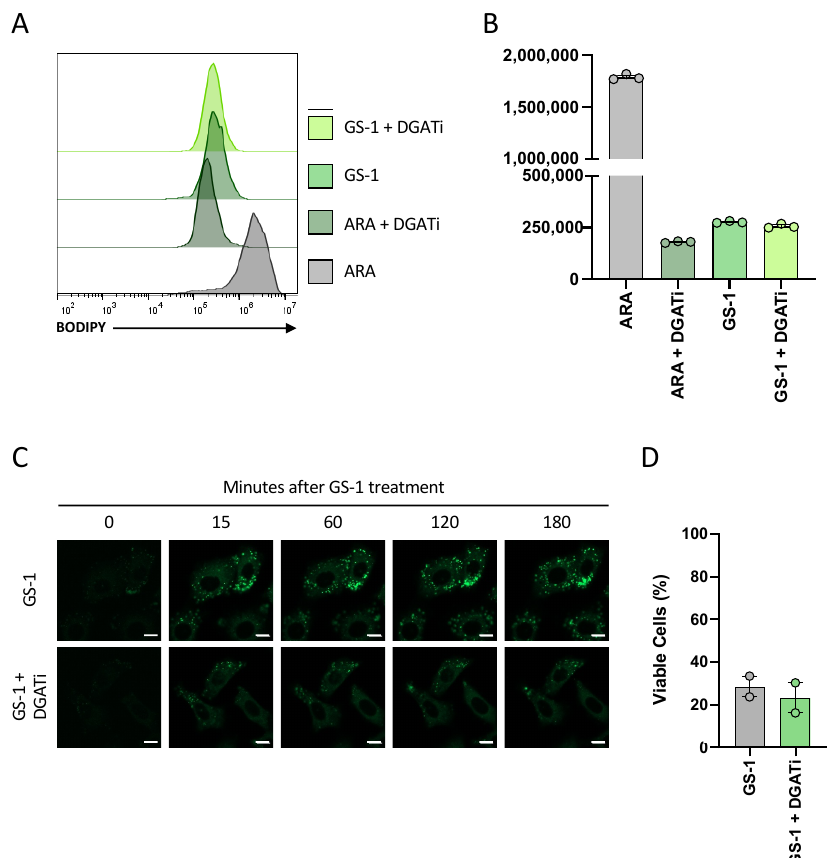
Figure 6. Role of LD in GS-1 cytotoxicity. A549 cells were treated with GS-1 and DGATi for 4 h before being stained with BODIPY. (A) BODIPY levels were plotted as histograms after flow cytometry analysis. BODIPY MFI was then quantified in (B) (Representative of n=3 experiments, ± S.E.M). (C) Confocal time course microscopy analysis of A549 cells treated with GS-1 in the presence of DGATi and stained with BODIPY (scale bar 10 µm; images representative of 3 ex-periments). (D ) A549 cells were treated GS-1 with or without DGATi for 24 h before undergoing an MTT assay to determine viability (n=2 independent experiments, ± S.E.M).